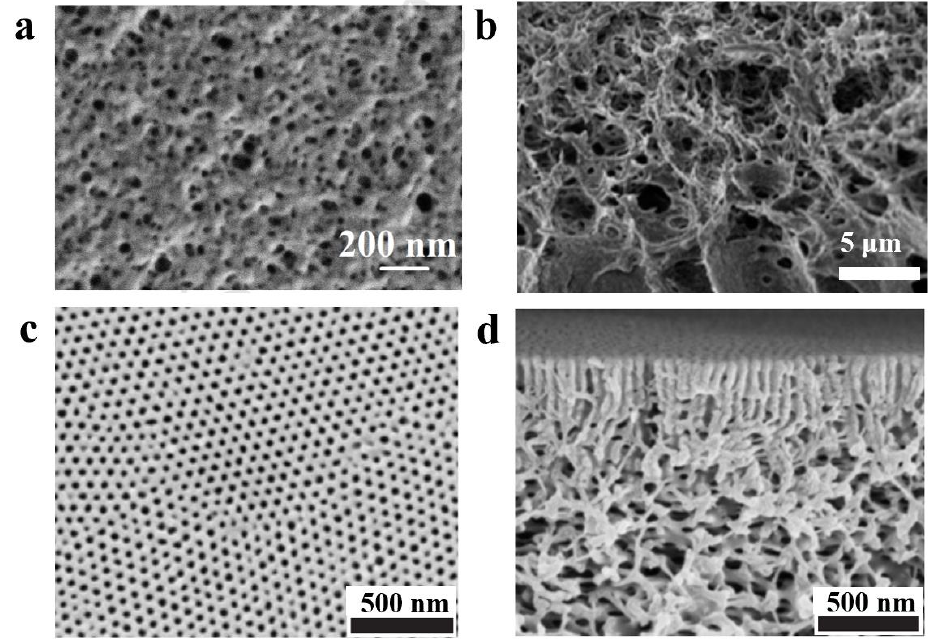
Figure 5. ( a ) SEM image of the surface of porous ultrafiltration membrane formed by the NIPS method for Pluronic F127 [85]. ( b ) SEM image of cross-section of multiporous sponge-like structure PI-b-PS-b-P4VP formed by NIPS method [86]. SEM images of the surface ( c ) and cross section ( d ) of PS-b-P4VP membrane obtained by SNIPS [93].